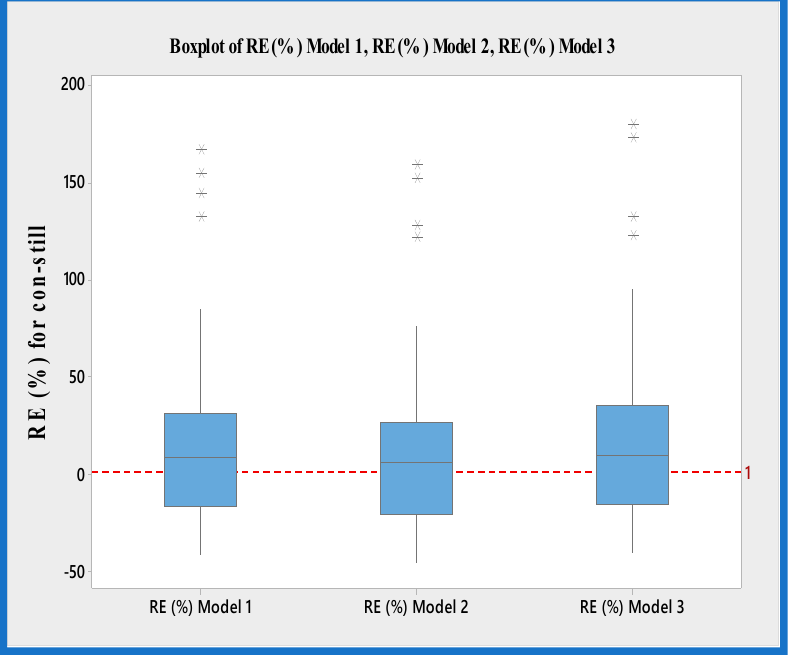
Figure 4. Boxplot comparing relative error (RE) values of Models 1, 2, and 3 (con-still). (Here the * sign represents outlier data points)